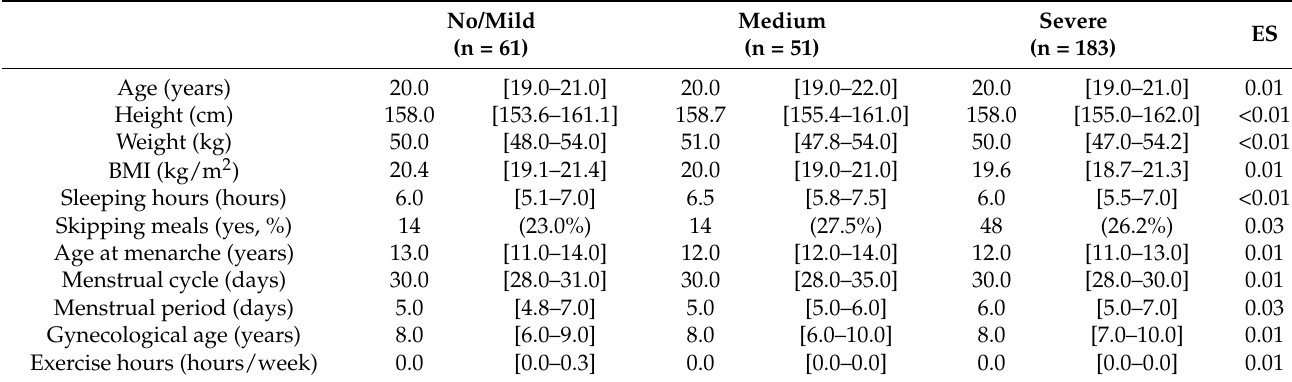
Table 3. Characteristics by severity of dysmenorrhea in non-athletes.